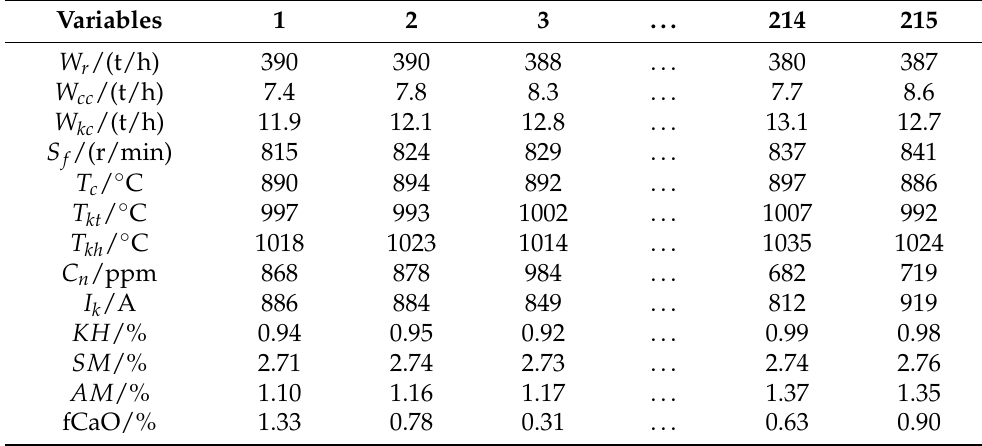
Table 2. Some collected process variables data